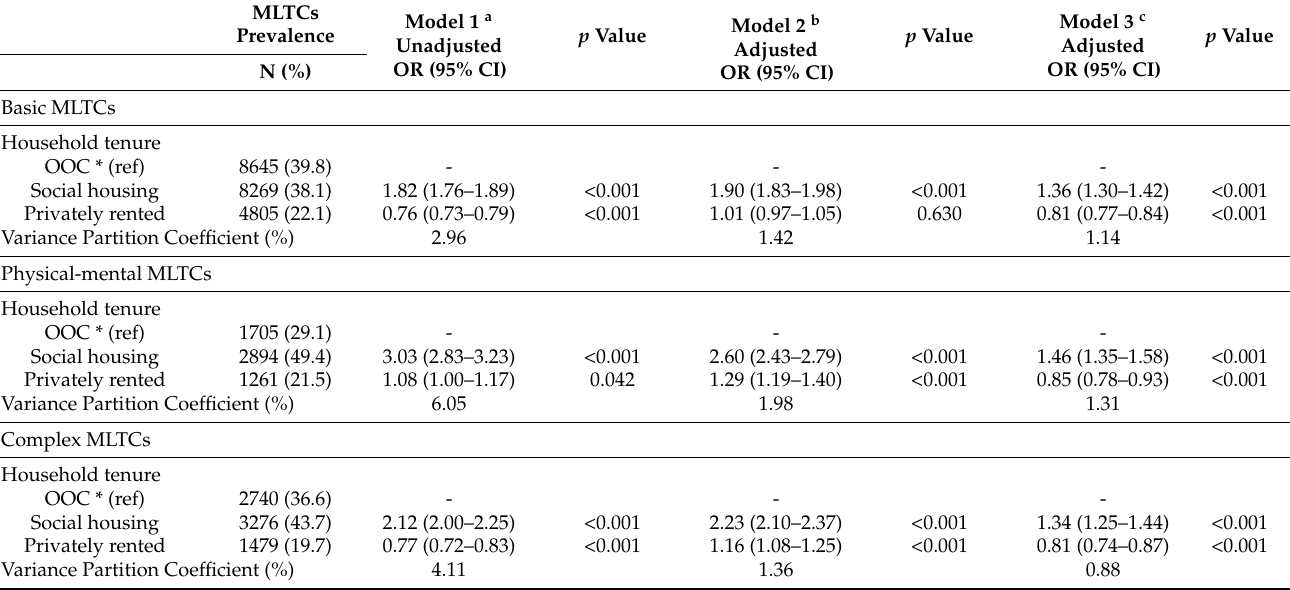
Table 2. Estimated odds ratios of multiple long-term conditions (MLTCs) with household tenure for working-age adult residents with complete data (N =